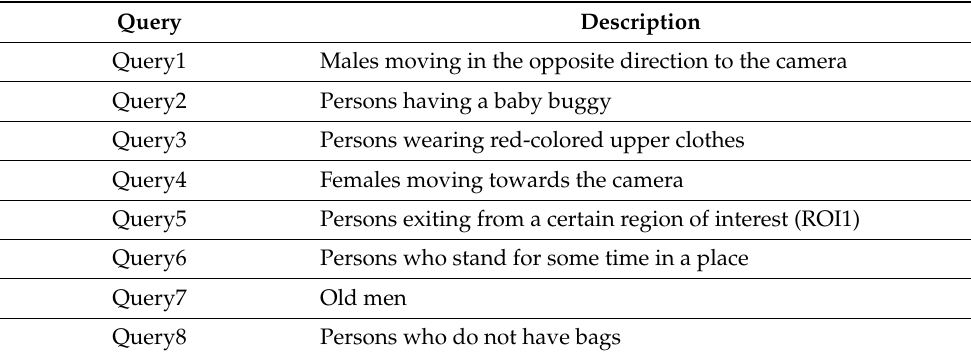
Table 1. Suggested queries for evaluating the proposed system